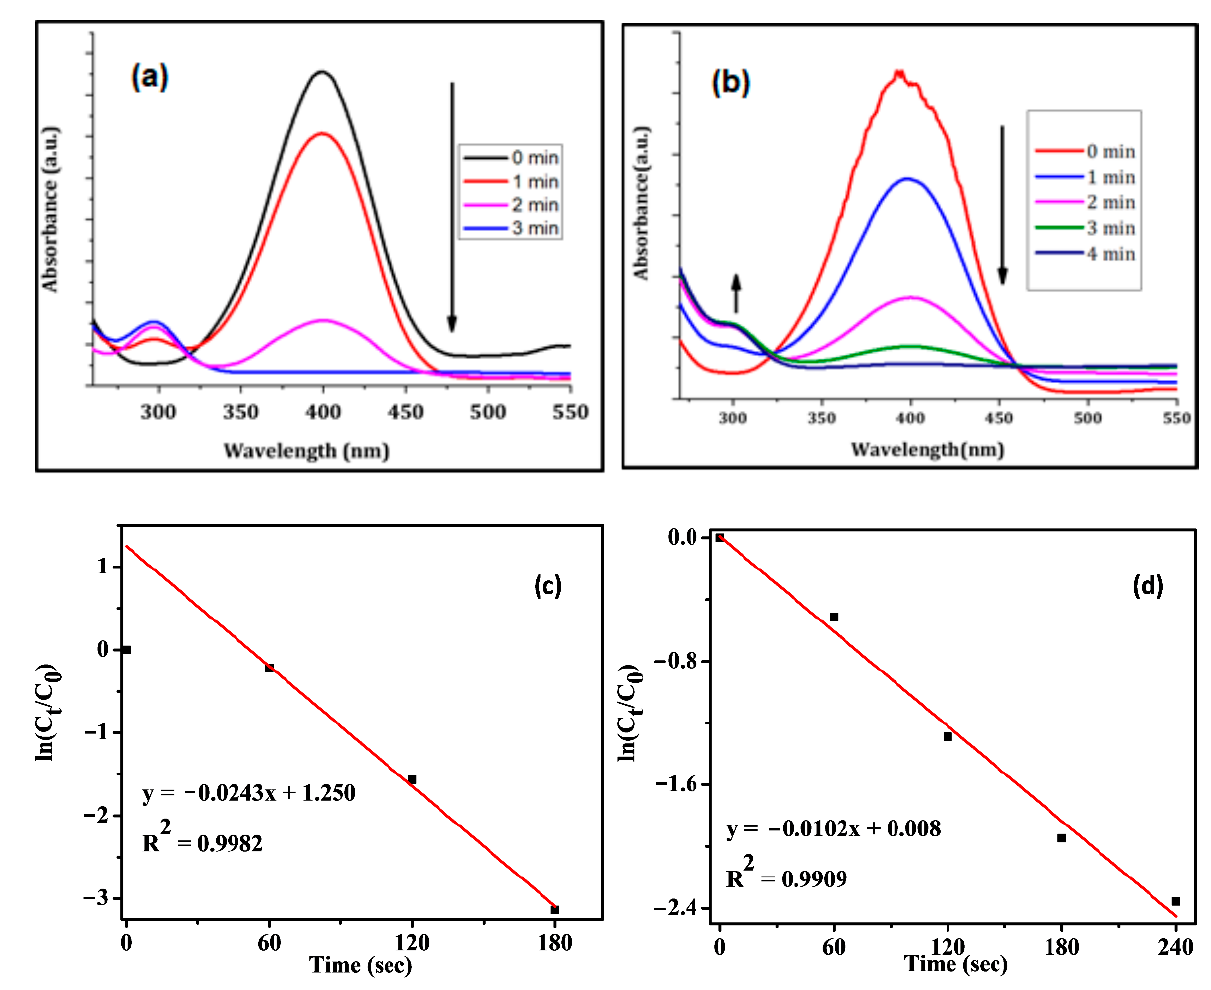
Figure 2. UV-vis spectra showing the successive reduction of 4-NP to 4-AP in the presence of ( a ) cluster 1 (corresponding kinetic plots ( c )) and ( b ) the derived AgNPs at room temperature (corresponding kinetic plots ( d )).